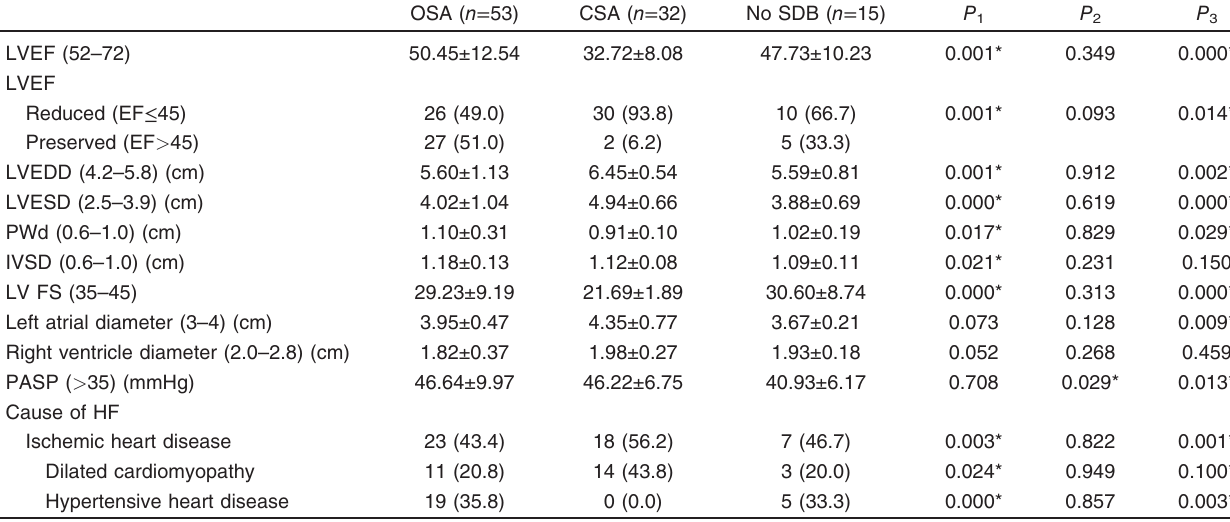
Table 6 Echocardiographic parameters between each of obstructive sleep apnea, central sleep apnea, and no sleep-disordered